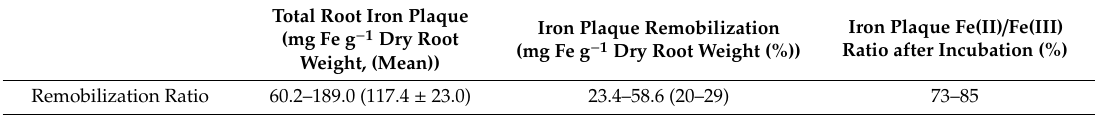
Table 2. Iron plaque formation, remobilization, and transformation during microbial Fe(II) reduction. Total iron plaque mineral formation on roots was quantified by mineral